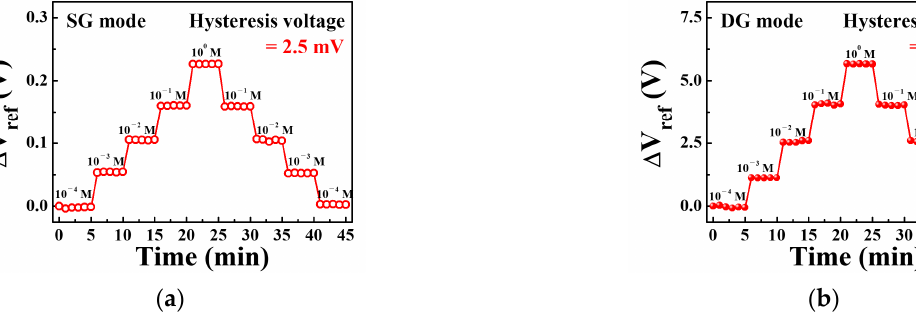
Figure 10. Hysteresis effects of the sodium ion sensor based on SiNW channel DG FETs with sodium-selective membrane EG during the ( a ) SG mode and ( b ) DG mode operations.